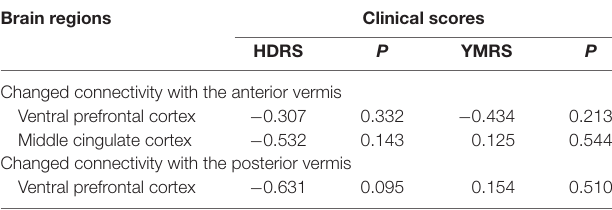
TABLE 3 | The correlation between the strength of these changed connectivity regions and the clinical scores in BD